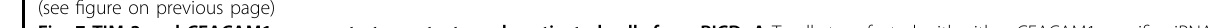
Fig. 7 TIM-3 and CEACAM1 cooperate to protect newly activated cells from RICD. A T cells transfected with either CEACAM1-speci fi c siRNA (CEACAM1 KD) or nonspeci fi c siRNA (NS) were assessed for RICD sensitivity on day 4 post-activation as previously mentioned. B Cells transfected with siRNA as in ( A ) on day 10 were assessed for RICD on Day 14 post-activation. C CEACAM1 KD ef fi ciency was evaluated using fl ow cytometry, plotted as fold decrease for individual experiments. D Newly activated cells were treated with increasing doses of CEACAM1-Fc chimera for 1 h prior to restimulation and assessed for apoptosis 24 h later using propidium iodide staining and fl ow cytometry. E Newly activated cells were treated with CEACAM1-Fc, CEACAM3- Fc, or CEACAM8-Fc chimera protein, or solvent control on Day 4 post-transfection and assessed for RICD sensitivity following OKT3 restimulation. F Late-stage effector cells (Day 14) were treated as in ( E ), dose ranging from 10 to 100 µg/mL. Asterisks denote statistical signi fi cance using the following tests: A paired t test, p = 0.0007; B paired t test, p = 0.1843; C Mann – Whitney test, p = 0.0286; D repeated measures one-way ANOVA, control vs. 1 µg/mL, p = 0.1312; control vs. 10 µg/mL, p = 0.0156, control vs. 100 µg/mL, p = 0.0127; E ordinary one-way ANOVA with multiple comparisons (corrected), control vs. CEACAM1 p = 0.0016; control vs. CEACAM3 p = 0.5216; control vs. CEACAM8 p =